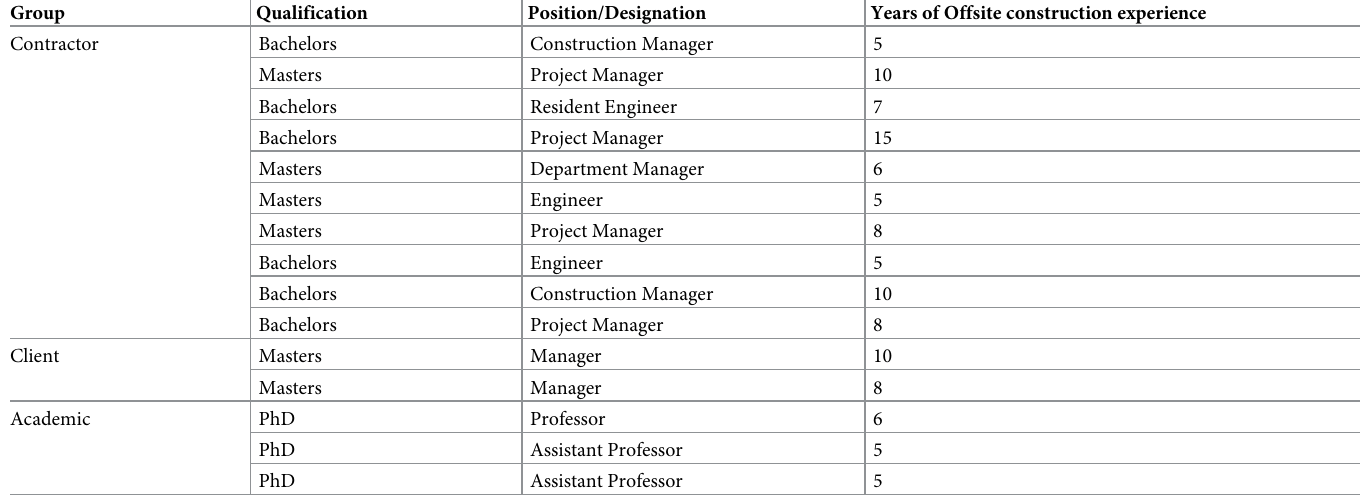
Table 3. Profile of